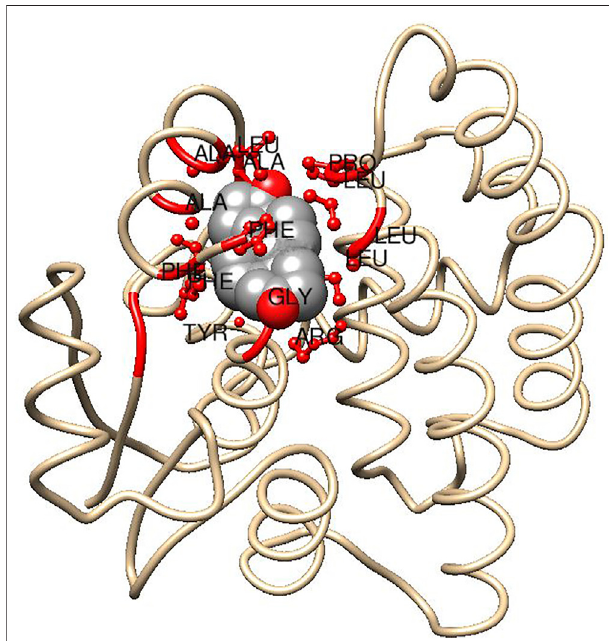
FIGURE 4 | Subunit of human GST A3-3 indicating H-site interactions with a bound steroid ligand. Fragments < 5.0 Å distant from the steroid molecule are indicated in red, including ball and stick representations of side chainsfrom(counterclockwise):Phe10,Tyr9,Gly14,andArg15(below); Leu107, Leu108, Pro110, and Leu111 (right); Ala208, Leu213, Ala216, Phe220,andPhe222(left).ThemodelisbasedonthecrystalstructureofGST A3-3 (PDB ID: 2vcv) in complex with the product 4-androsten-3,17-dione usingChimera1.15(Pettersenetal.,2004).Itisassumedthatthesubstrate5- androsten-3,17-dione binds in a similar pose subject to the conformational adjustments for the interchange of the sp 3 and sp 2 hybridizations of C4 and C6 in the two isomeric steroid molecules (cf. Figure 2